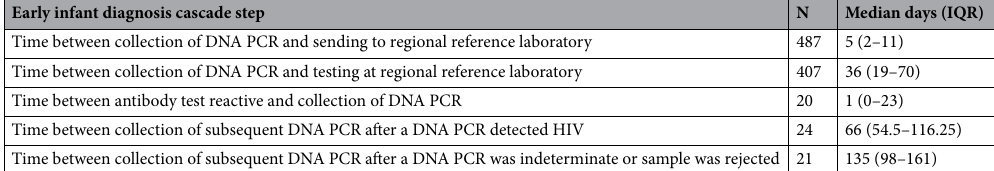
Table 1. Median time for steps in early infant diagnosis